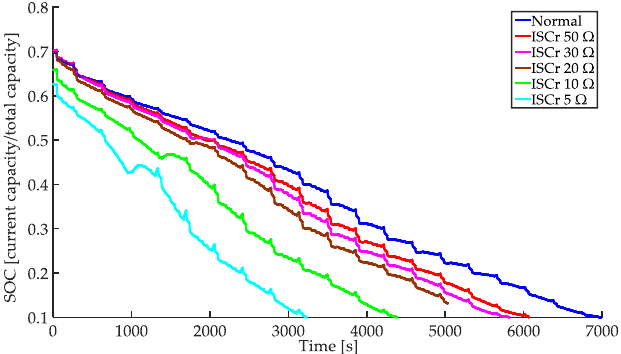
Figure 4. Comparison of estimated SOCs of normal cell and cell with ISCr (experiment: cell A, DST 5 A, ISCr 50 Ω, 30 Ω, 20 Ω, 10 Ω and 5 Ω).